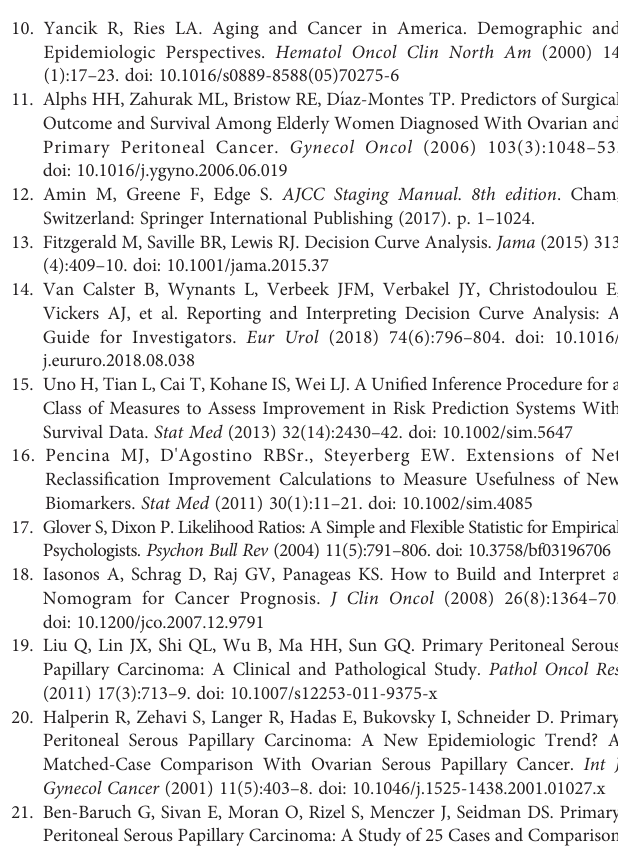
Supplementary Figure 1 | Calibration curves for predicting the 3-, 5-, and 10- year OS of PPSC patients in the training (A – C) , internal validation (D – F) , and external validation (G , H) cohorts. Supplementary Figure 2 | Decision curve analysis of the nomogram and FIGO staging system for predicting the 3-, 5-, and 10-year OS of PPSC patients in the training (A – C) , internal validation (D – F) , and external validation (G , H) cohorts. Supplementary Figure 3 | The 3-, 5-, and 10-year OS of 0.530, 0.330, and 0.137 automatically predicted by the web calculator for a woman of PPSC, aged 60, married, grade high, FIGO IV, lymph node metastasis, debulking surgery, chemotherapy, and